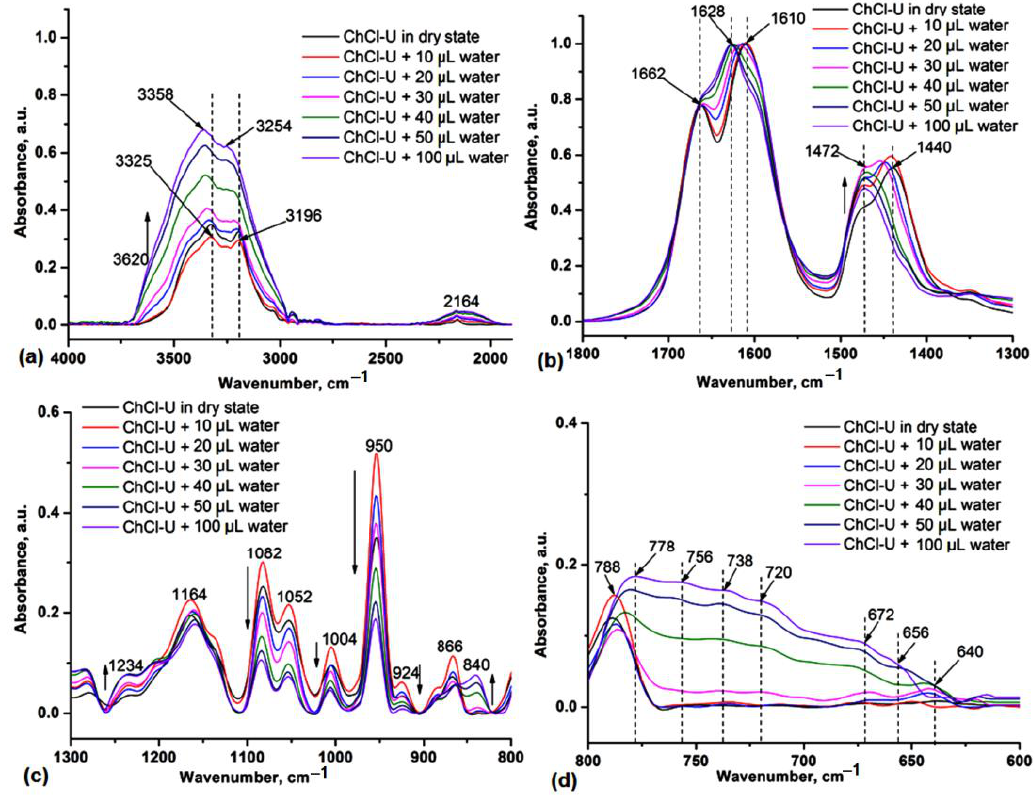
Figure 2. IR spectra of ChCl-U during the addition of water in the 4000 – 1800 cm −1 ( a ), 1800 – 1300 cm −1 ( b ), 1300 – 800 cm −1 ( c ) and 800 – 600 cm −1 ( d ) spectra range. The vertical dashed lines highlight the shifts of the main absorptions in the presence of different amounts of water.